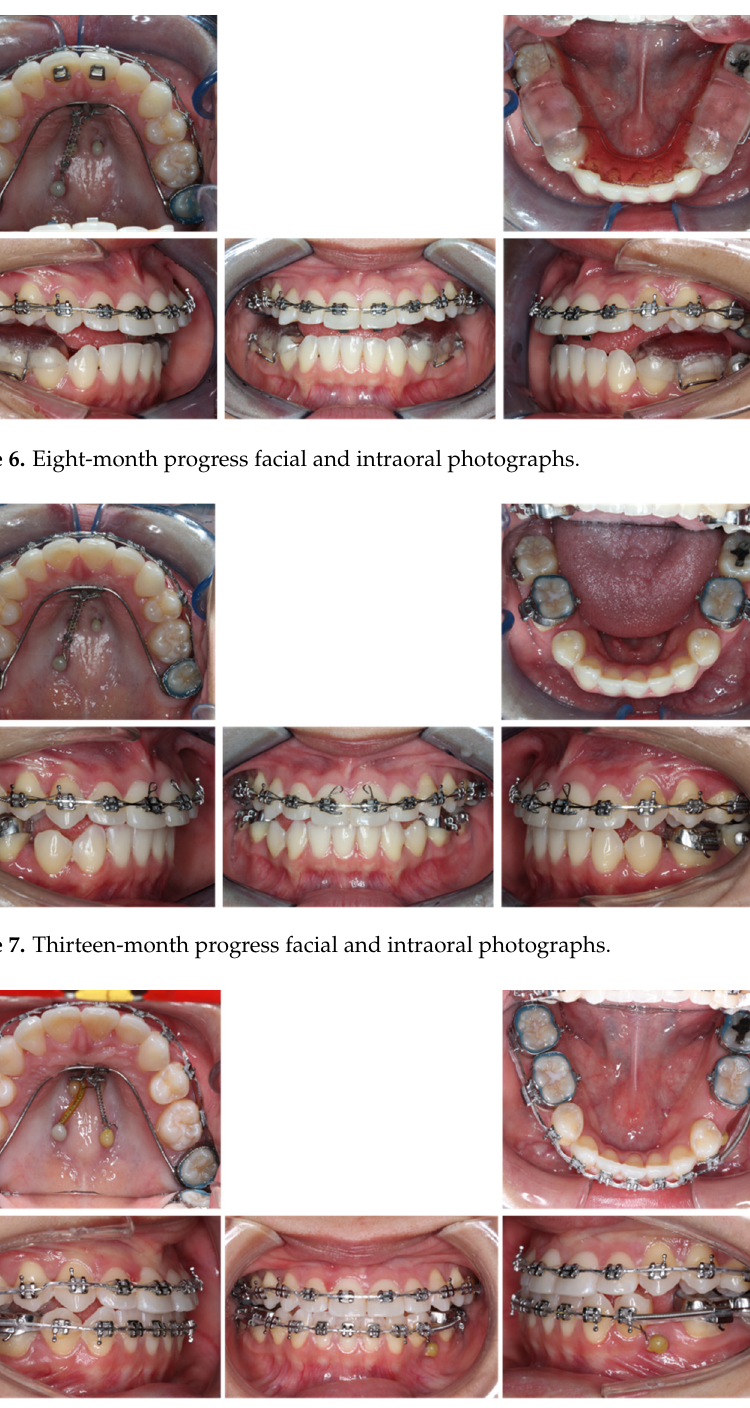
Figure 8. Thirty-fifth-month progress facial and intraoral photographs.